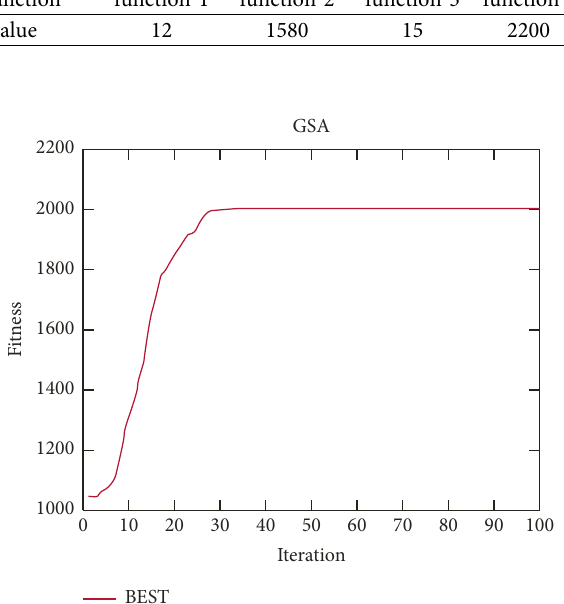
Figure 3: The value of the combined objective function for various By determining the optimal values of the variables, the optimal values of the four-objective functions considered are calculated according to Table 5.